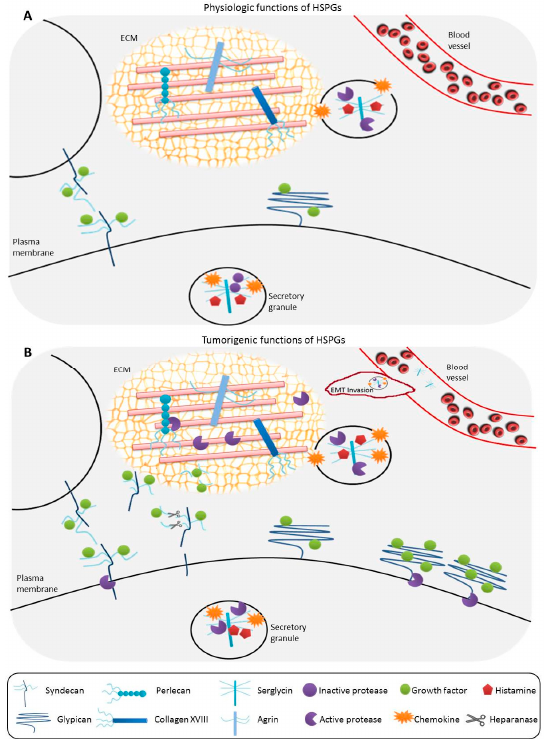
Figure 1. ( A ) Under physiologic conditions, syndecans are located at the cell surface, functioning as growth factor receptors and are important for cell-to-cell communication. Glypicans are also located at the cell surface, attached to the membrane through a glycosylphosphatidylinositol (GPI) anchor, and function as growth factor receptors. Perlecan, agrin, and serglycin are found within the extracellular matrix (ECM) and aid in the formation and structural integrity of the ECM barrier. Serglycins are the only intracellular heparan sulfate proteoglycans (HSPGs), found in secretory granules with chemokines and histamine, and function in maintaining proteases in their inactive form. Upon secretion, serglycins activate ECM proteases and are important in regulation of host defenses and wound repair; ( B ) In tumorigenesis, syndecans can be proteolytically cleaved, and these soluble syndecans can sequester growth factors in the ECM. Heparanases can cleave HS chains, which can also bind and complex with growth factors in the ECM. Glypican expression at the cell surface is often upregulated, resulting in increased growth factor binding and uptake which mediates tumor cell growth. Tumor cells have increased serglycin secretion, causing enhanced protease activity, facilitating ECM breakdown that promotes tumor invasiveness and metastasis.